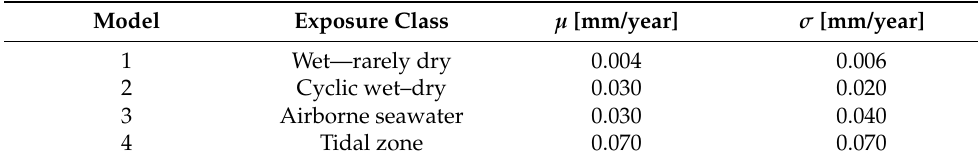
Table 6. Different parameters for the distribution of the corrosion rate based on [53].